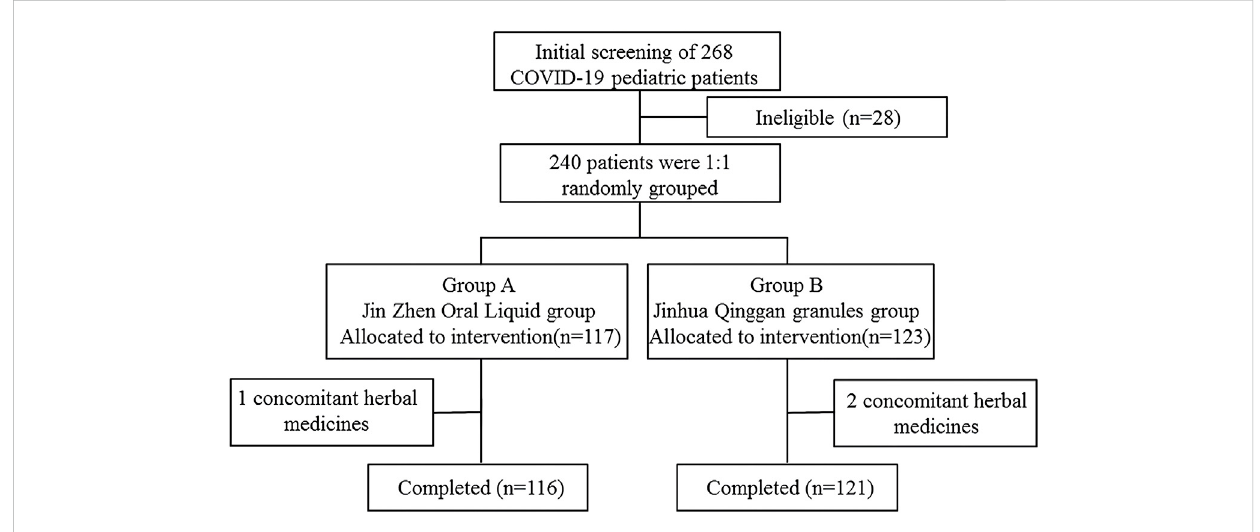
FIGURE 1 Flowchart of screening, randomization, and treatment of